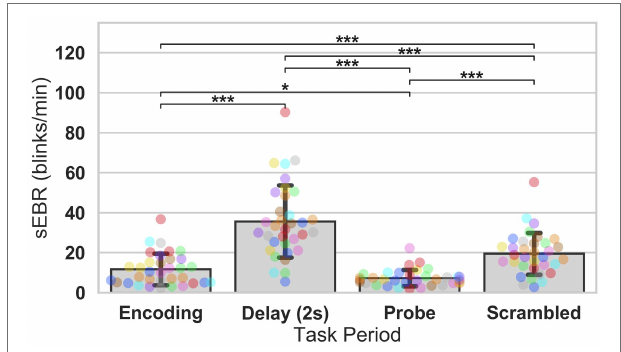
FIGURE 6 | ANOVA test of sEBR across task periods in Experiment 2. Bar plots show task period on the x-axis and sEBR on the y-axis. Delay period sEBR was significantly greater than Encoding, Probe, and Scrambled sEBR. Scrambled sEBR was also significantly greater than Encoding and Probe sEBR. Encoding sEBR was significantly greater than Probe sEBR. Error bars depict 95% confidence interval. Each colored circle represents an individual participant; some colors may be presented twice in one bar due to limited primary colors available for display. Values of p were adjusted for comparing a family of 4. * p < 0.05, and *** p < 0.001.